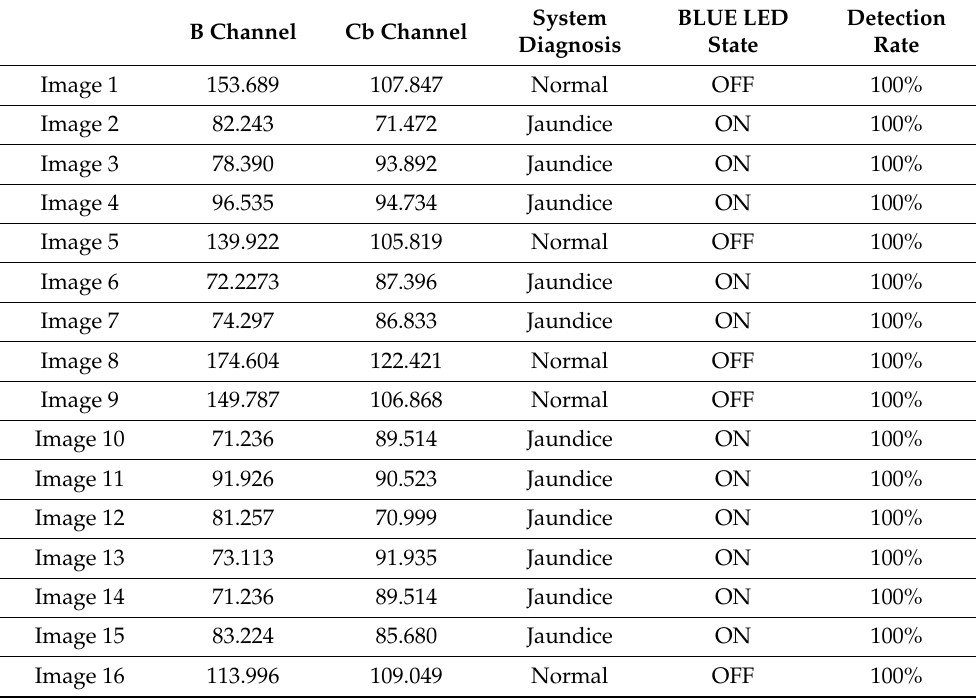
Table 2. The summary of all images considered in scenario